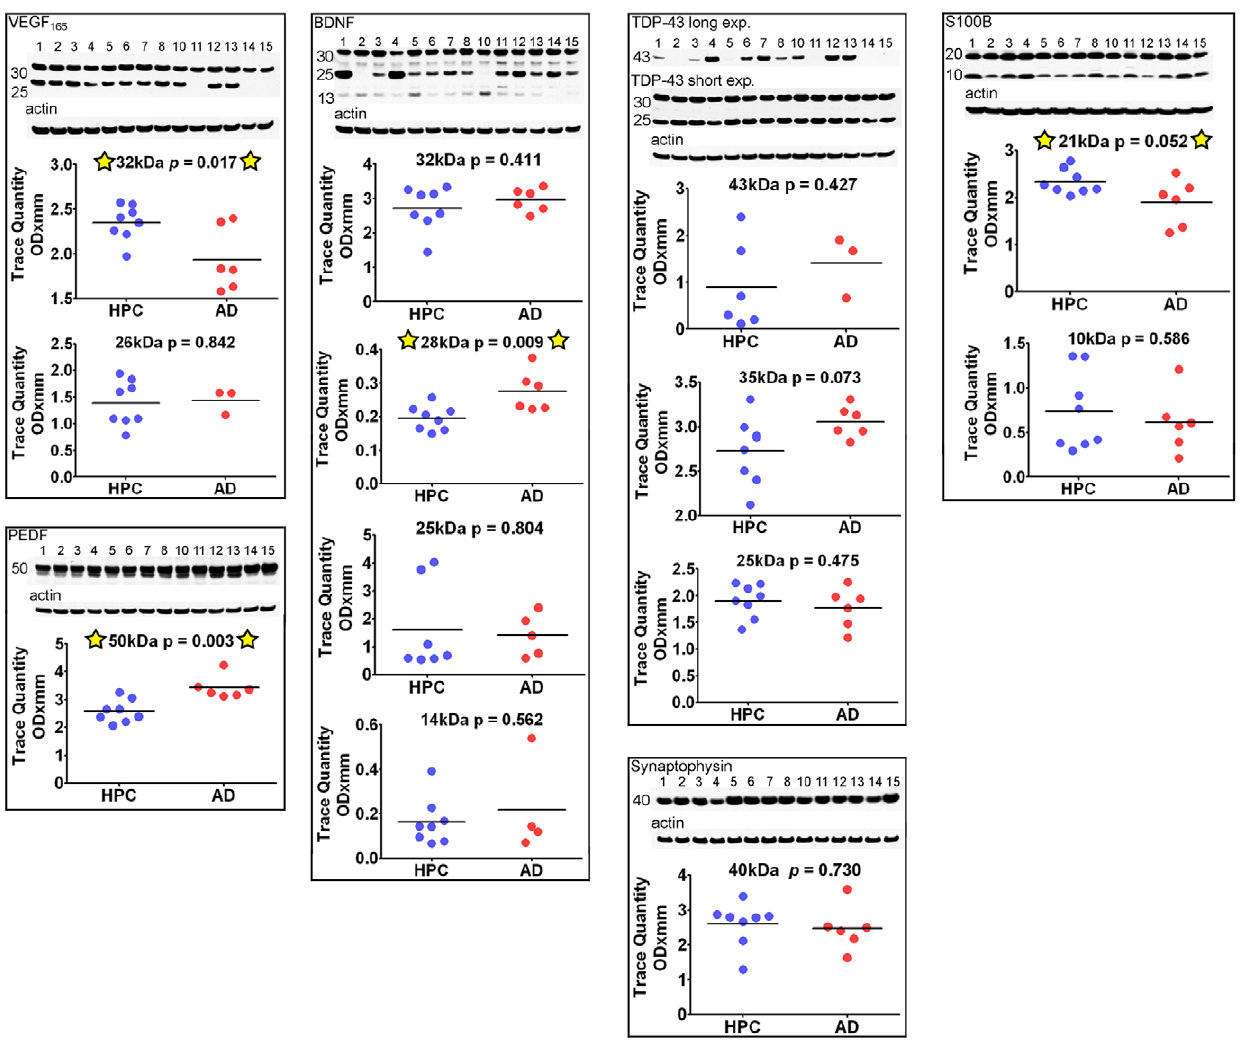
Figure 7. Western blots of VEGF, PEDF, BDNF, TDP-43, synaptophysin and S100B. Forty m g of total protein was loaded onto VEFG, BDNF and TDP-43 acrylamide gels. The PEDF and synpaptophysin blots contained 20 m g and 10 m g of total protein, respectively. Unpaired, 2-tailed t-tests were used for statistical analysis. The primary and secondary antibody descriptions and sources are given in Table 2 . The relative abundance of the proteins were densitometrically estimated. Each blot was reprobed with actin as a loading control, as shown at the bottom of each primary antibody Western blot. The numbers to the left of the Western blots are the molecular weight in kDa. HPC = non-demented high pathology controls; AD = Alzheimer’s disease; exp =